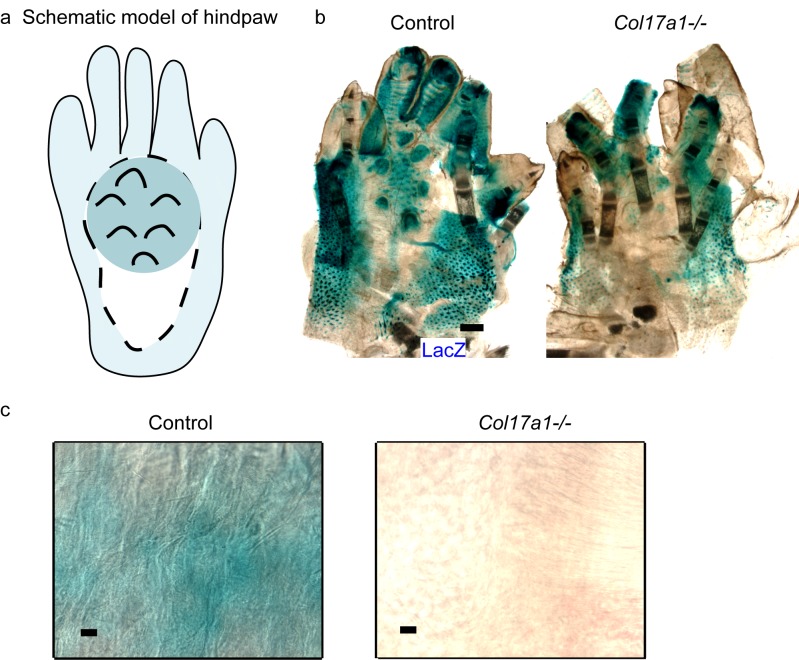
The details of LacZ staining in ins-Topgal+ mice with COL17 deficiency.(a) Schematic model of murine hindpaw on LacZ staining. The dark blue area indicates sweat glands-abundant regions and the light blue area represents to regions with hair follicles. Sweat glands and hair follicles are major sources of Wnt activities as marked with LacZ. The white area, without sweat glands or hair follicles, shows the regions used for the quantification. (b) Gross appearance of LacZ staining on ins-Topgal+ (Control: left) and ins-Topgal+:Col17a1−/− (Col17a1−/−: right) mice hind paw. Scale bar: 500 μm. (c) LacZ staining on ins-Topgal+ (Control: left) and ins-Topgal+:Col17a1−/− (Col17a1−/−: right) mice in high magnification for quantification. Scale bar: 100 μm.